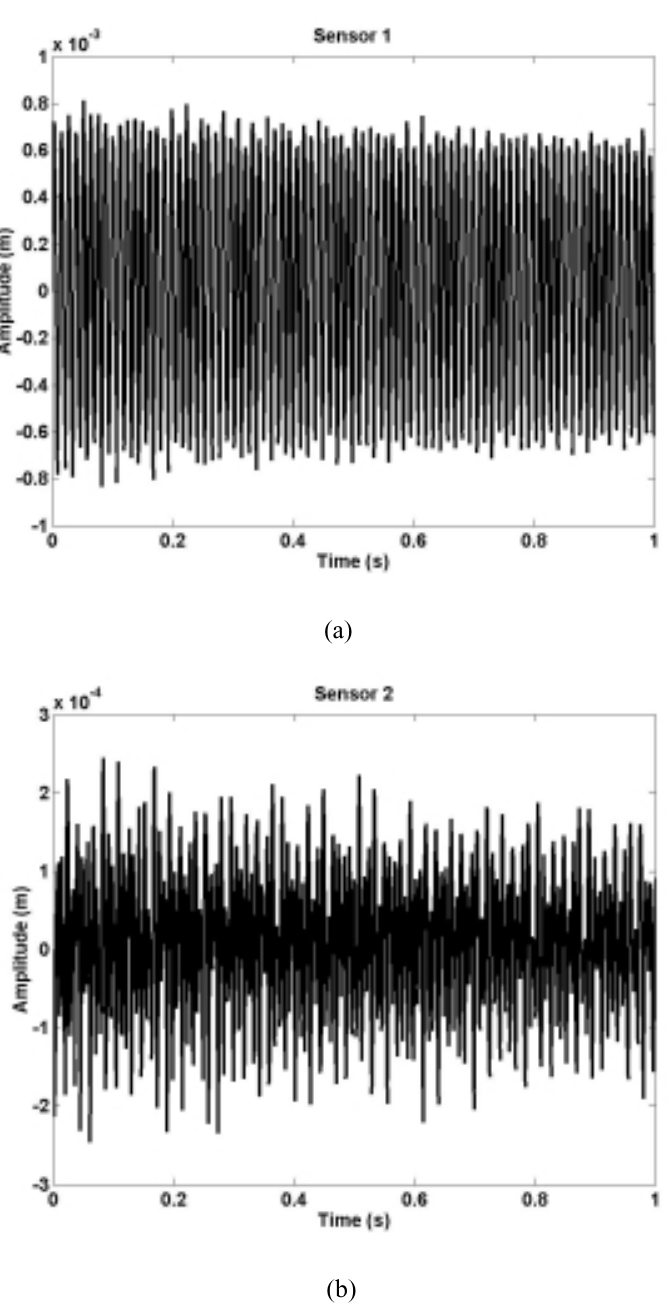
Fig. 3. Uncontrolled response for the reduced model with an impulsive force at (a) sensor 1 and (b) sensor 2. (cid:10) (cid:11) − 1 Φ T B Φ T M Φ where L = t . An independent controller can be designed for each mode, hence the modal feedback force in each mode u i is dependent on q mi and ˙ q mi alone, so that